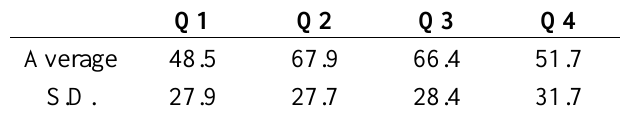
Table 2. Average and standard deviation for Questions 1 to 4 of the preliminary